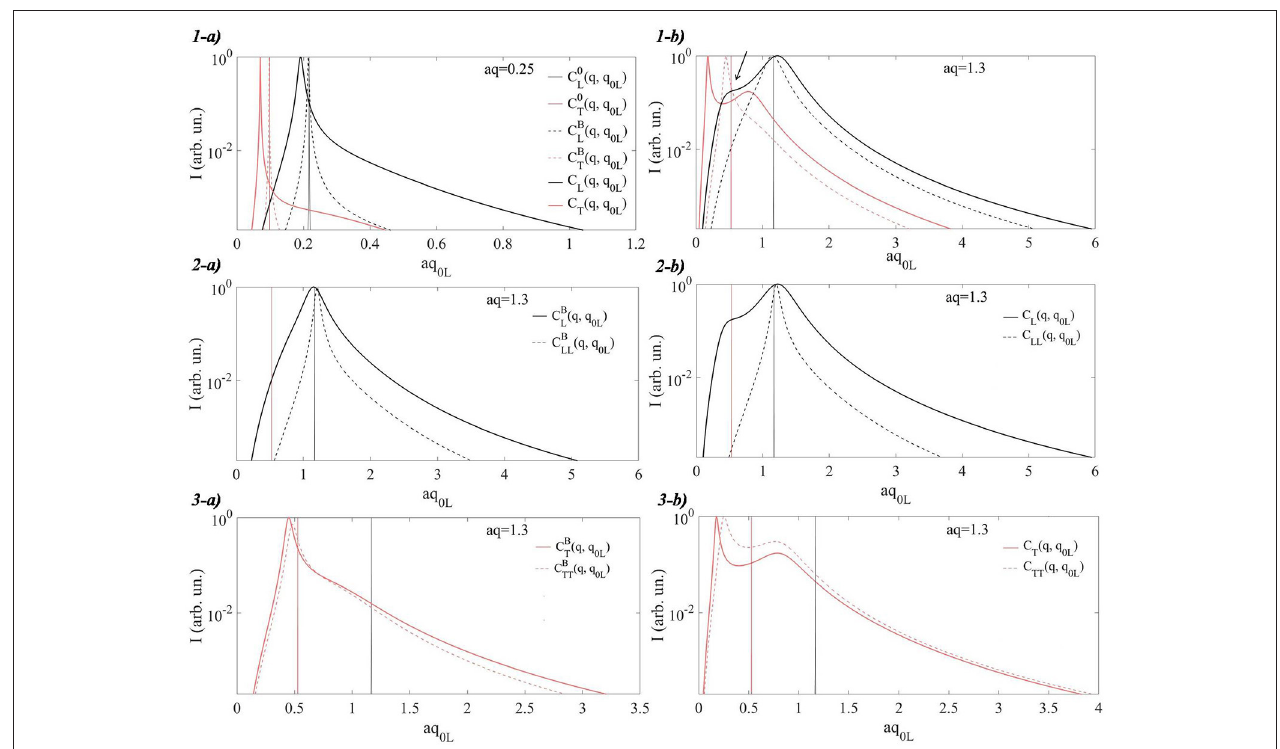
FIGURE 6 | (1) Longitudinal and transverse currents (black and red lines respectively) obtained by exploiting the GBA (full line) and the Born Approximation (dashed line) in the case of an exponential decay of the covariance function for different values of wavevector. The values of the theory’s input parameters, listed in the text, are the same for both approximations. (2) Longitudinal currents obtained by exploiting the Born Approximation, a ), and the GBA, b ). Full lines show the currents obtained by considering the full expression of the self-energy, 6 L ( q , ω ), dot-dashed lines show the currents obtained by considering the only longitudinal contribution to the self-energy, 6 LL ( q , ω ). (3) Transverse currents obtained by exploiting the Born Approximation, a ), and the GBA, b ). Full lines show the currents obtained by considering the full expression of the self-energy, 6 T ( q , ω ), dot-dashed lines show the currents obtained by considering only the transverse contribution to the self-energy, 6 TT ( q , ω